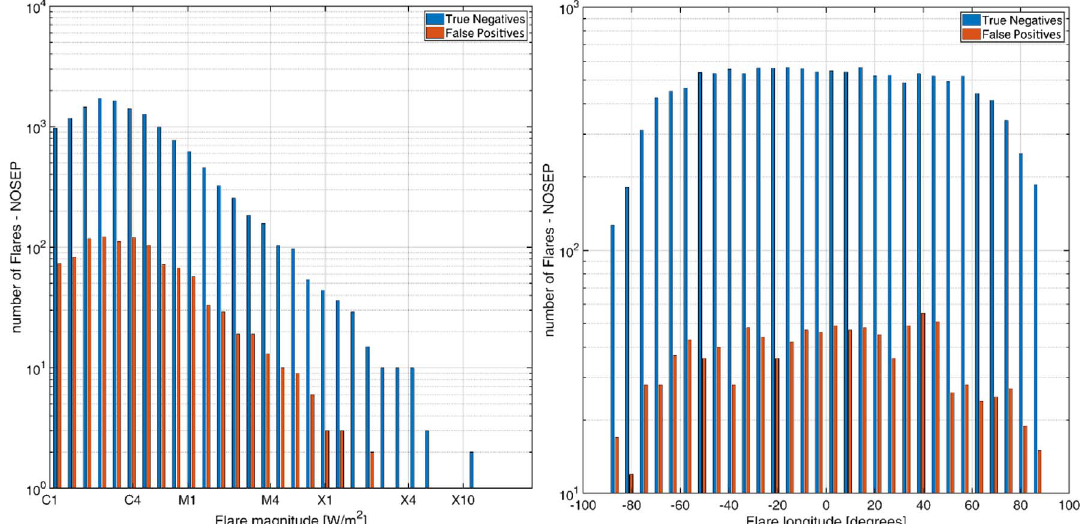
Fig. 10. The number of true negative fl ares and false positives. Left panel: in 30 logarithmic bins of the magnitude of their associated SFs. Right panel: in 30 bins of heliongitude.